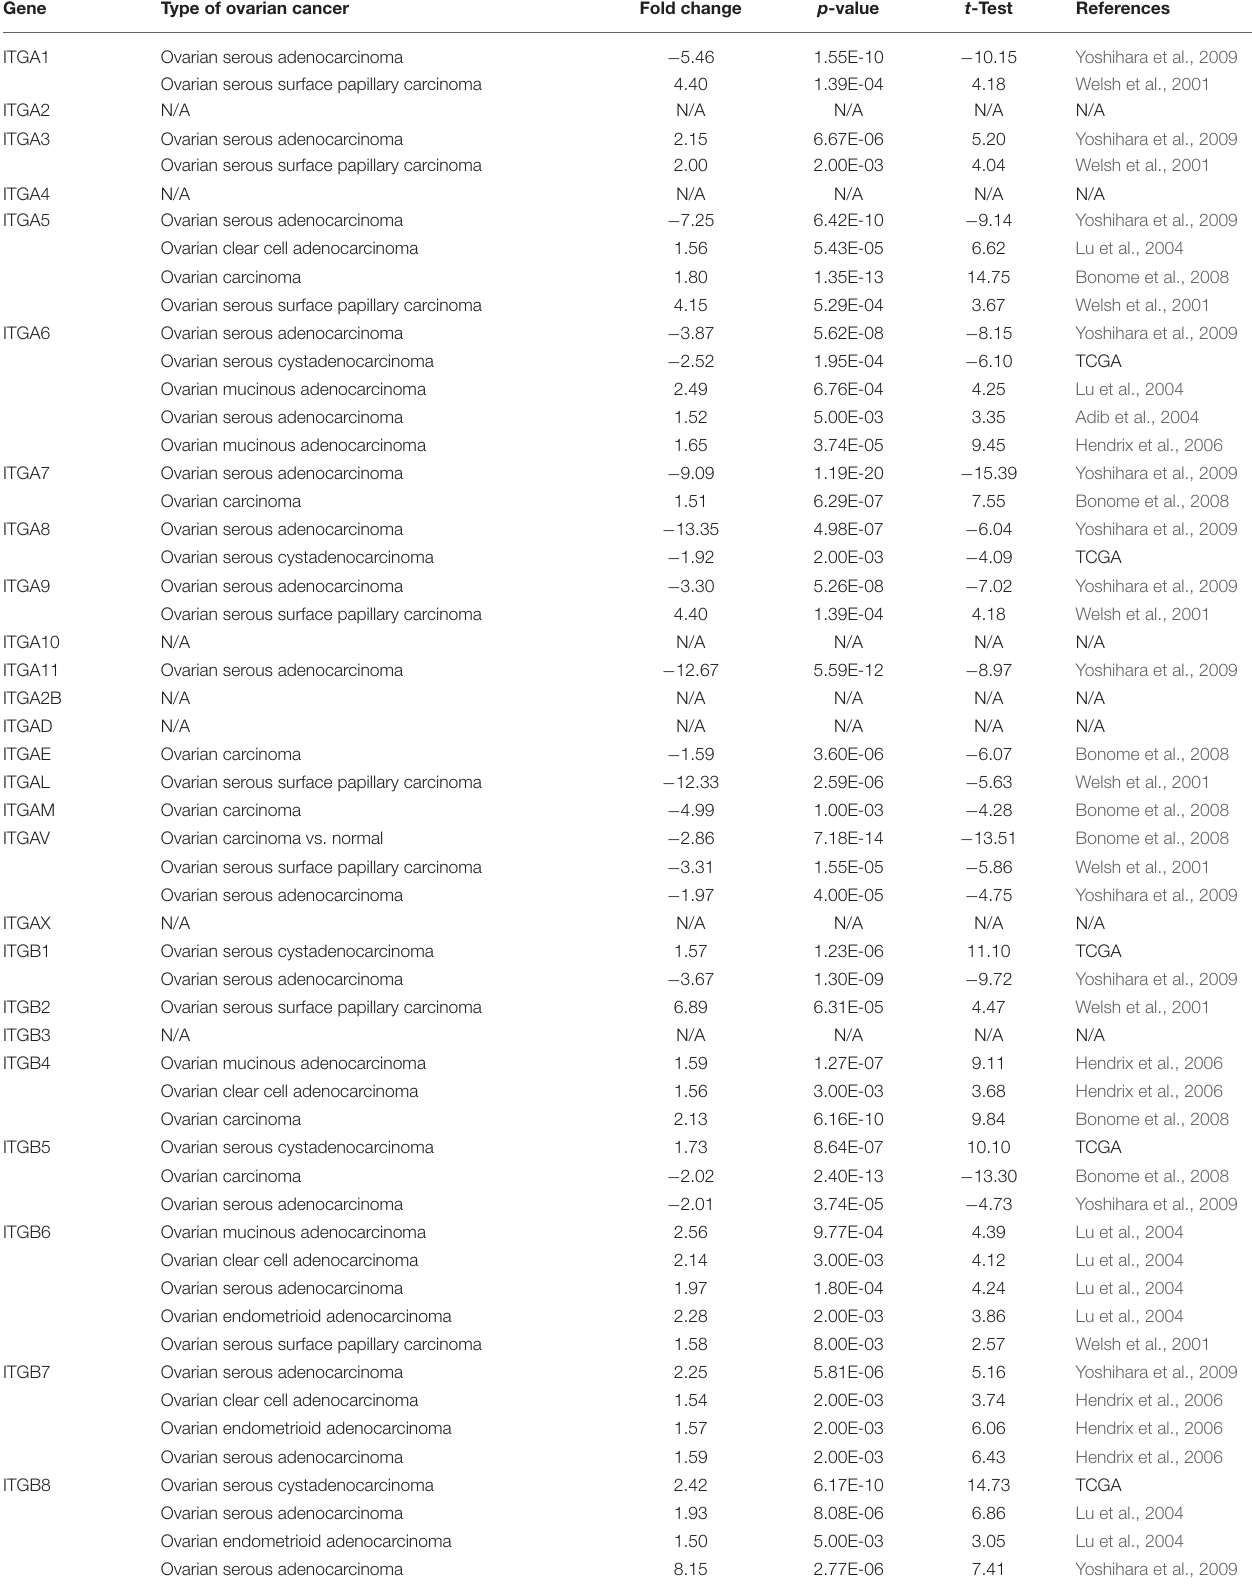
TABLE 1 | Significant expression changes of integrin genes in transcriptional level between OC and normal tissue (Oncomine). Gene Type of ovarian cancer Fold change p -value t